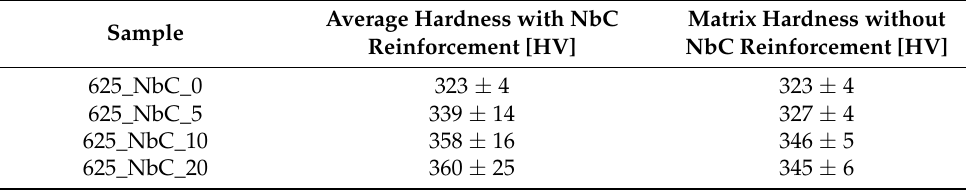
Table 7. Hardness of Inconel 625-NbC materials.